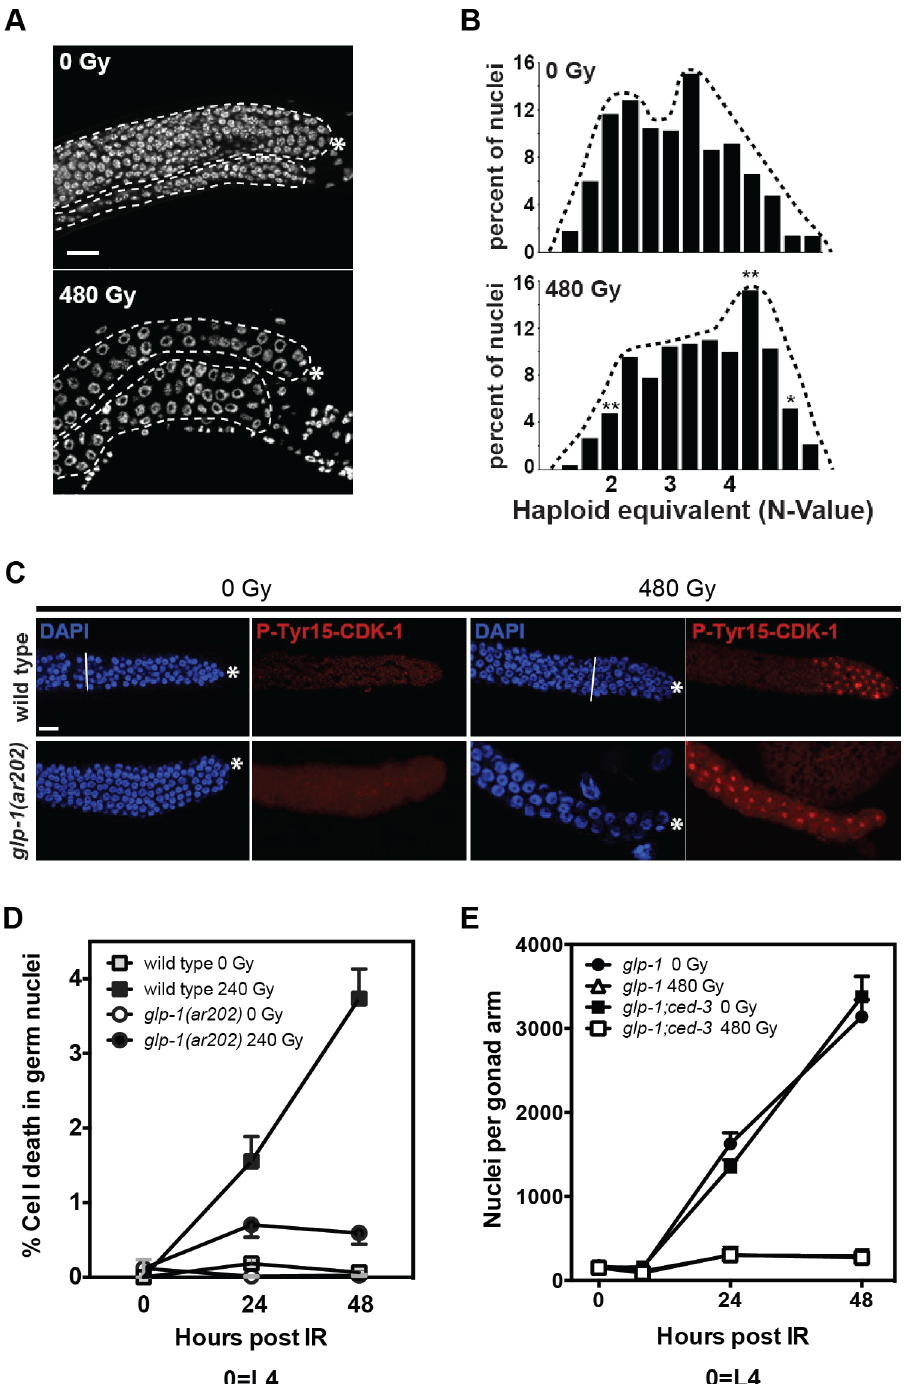
Fig 2. Tumor cells in glp-1(ar202) arrest in G2 phase following radiation exposure, and are apoptosis resistant. (A) Worms were irradiated at L4 stage and after 12h stained with DAPI. Representative germline tumors are outlined. (B) Relative nuclear DNA content of distal germ nuclei in unirradiated (0Gy) or irradiated (480Gy) worms. A total of 207 nuclei from 5 unirradiated worms, and 147 nuclei from 5 irradiated worms were scored. ( * p < 0.05; ** p < 0.01 relative to non-irradiated control). (C) Wild-type and glp-1(ar202) unirradiated or irradiated germline are stained with anti-phospho-Tyr15-CDK-1 antiserum (red) and DAPI (blue) as in Methods. White bar indicates border of proliferative zone. Asterisk indicates position of distal end. Scale bar is 20 μ m. (D) Comparison of radiation-induced germ cell apoptosis in wild type and glp(ar202) . Wild type and